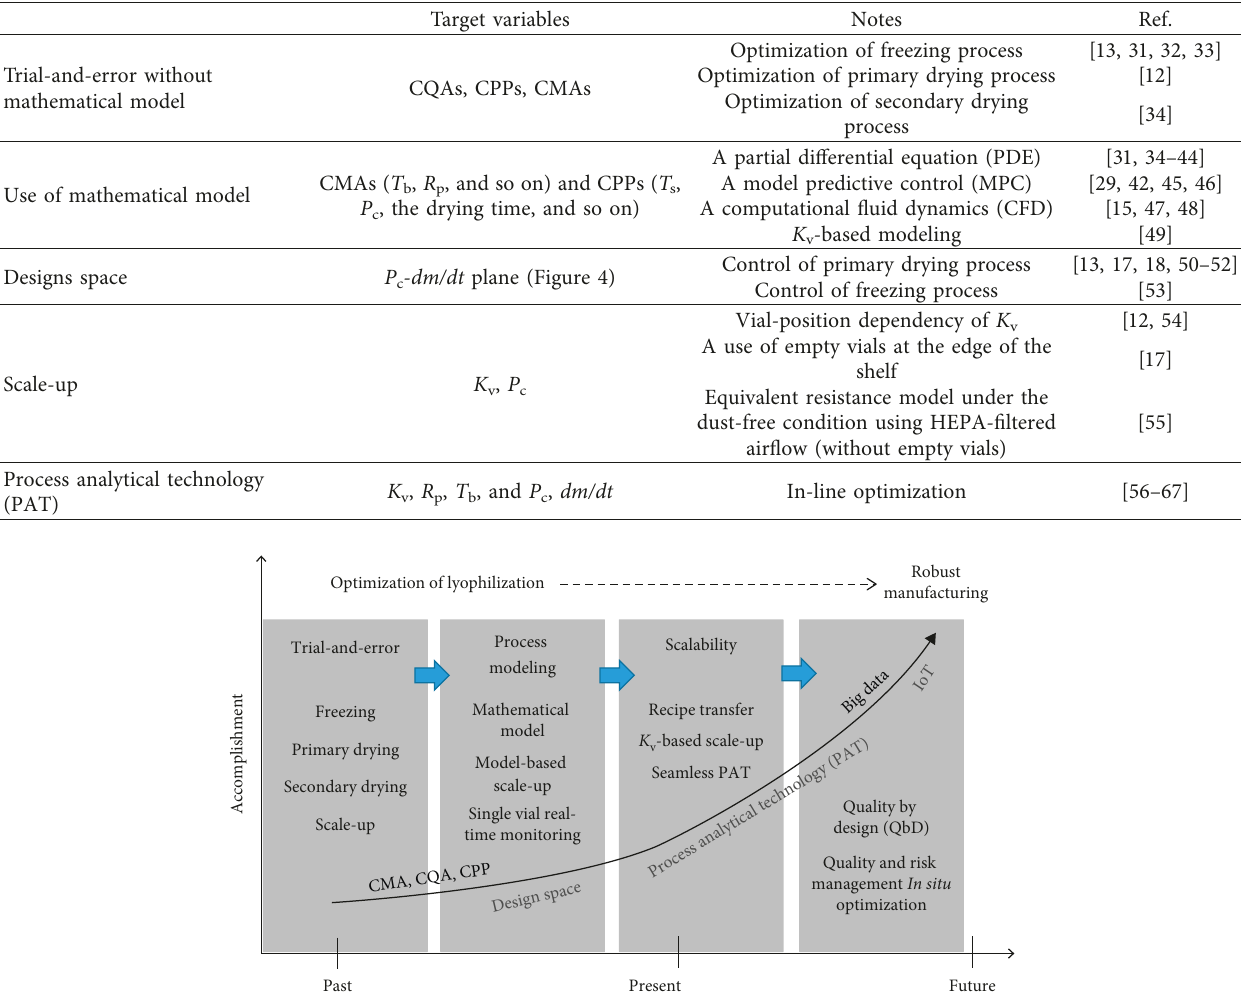
Figure 2: Possible technological transition and sublimation of lyophilization strategy for QbD in the pharmaceutical field. CQA: critical quality attribute; CPP: critical process parameter; CMA: critical material attribute; IoT: Internet of things.